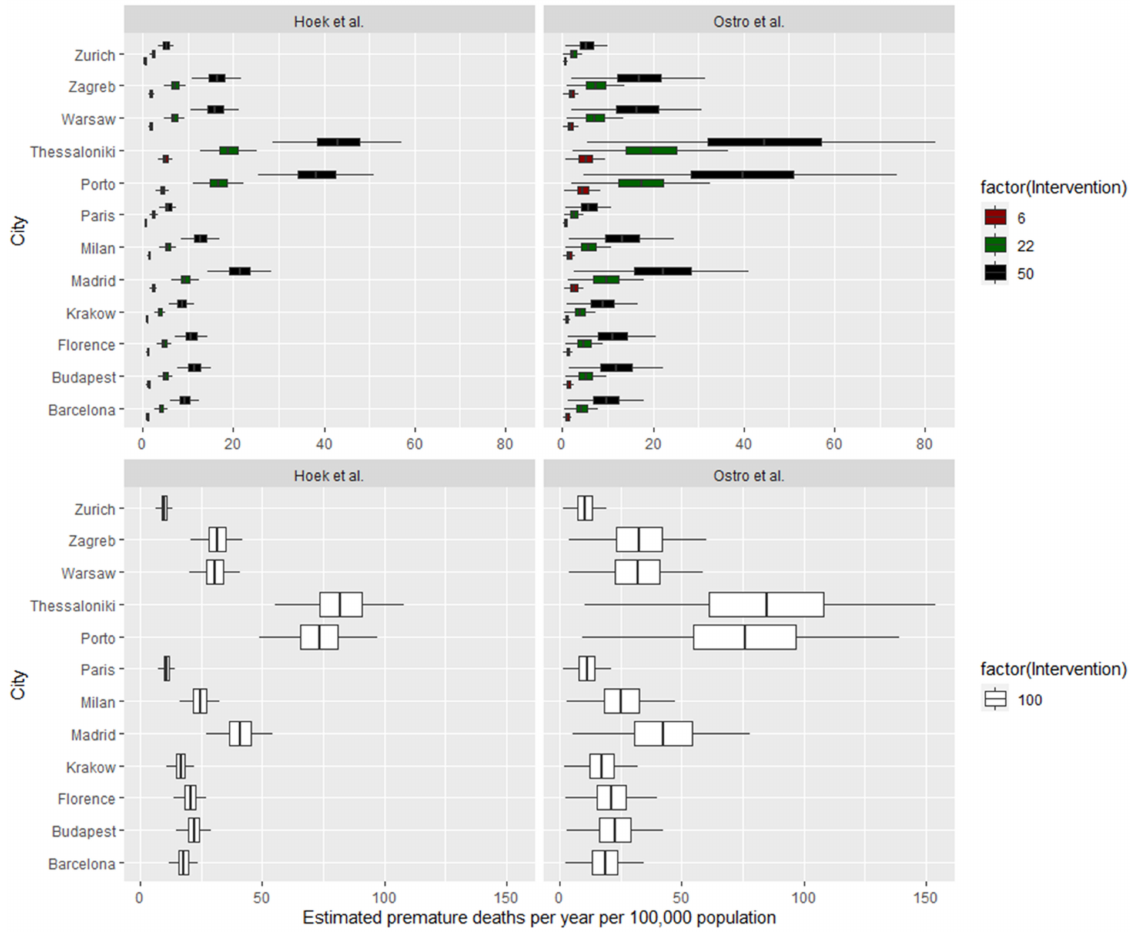
Figure 5. Estimated premature mortality/year per 100,000 population due to exposure to traffic- related PM 2.5 (baseline scenario) in the study cities, using two different risk estimates (as reported by Ostro et al. [45] and Hoek et al. [68]), and applying three different intervention scenarios (5, 22 and 50% reduction in concentrations). It is shown in comparison with the baseline/control scenario (100% reduction). The line within the box plots shows the median concentrations, while the box bottom and top represent the 25th and 75th percentiles, respectively. The whiskers represent the lower (2.5th percentile) and the upper (97.5th percentile) bounds. Note on the different x